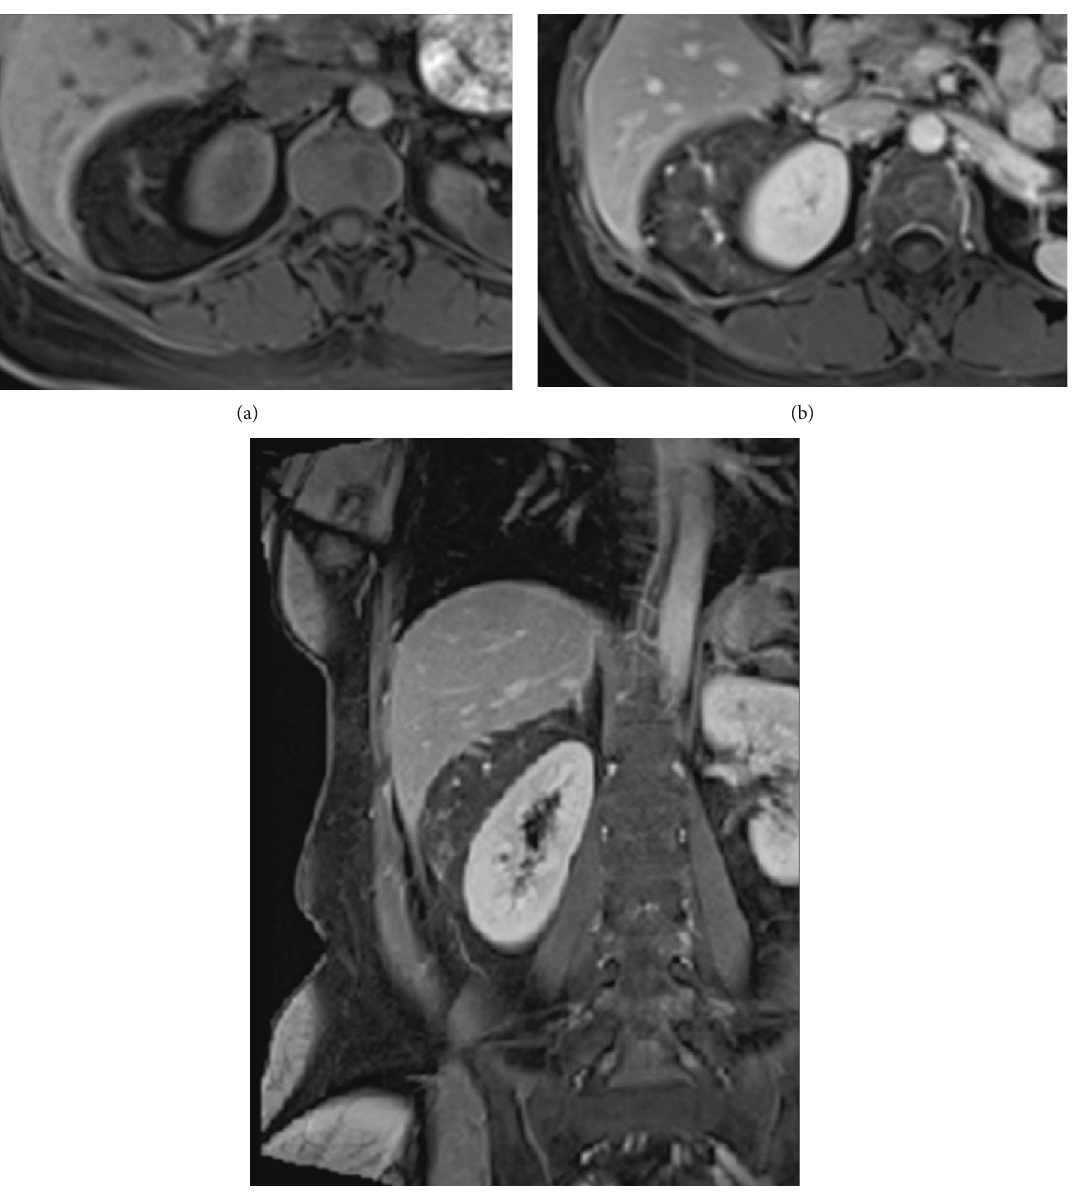
Figure 2: Magnetic resonance imaging fi ndings. (a) Fat-suppressed T1-weighted scans. The tumor was mainly composed of a homogenously low-intensity area, including a weakly high-intensity area with thick irregular septum-like structures. (b) Dynamic contrast-enhanced image. The septum-like structures showed strong enhancement. There was no beak sign or sharp beak shape arising from the kidneys. (c) Coronal section of dynamic contrast-enhanced image. The tumor surrounded the right kidney with no beak